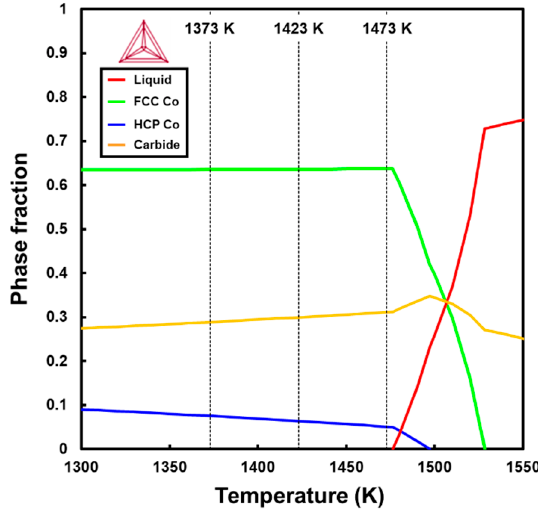
Figure 2. Relationship between the phase fraction and temperature for Stellite-1.